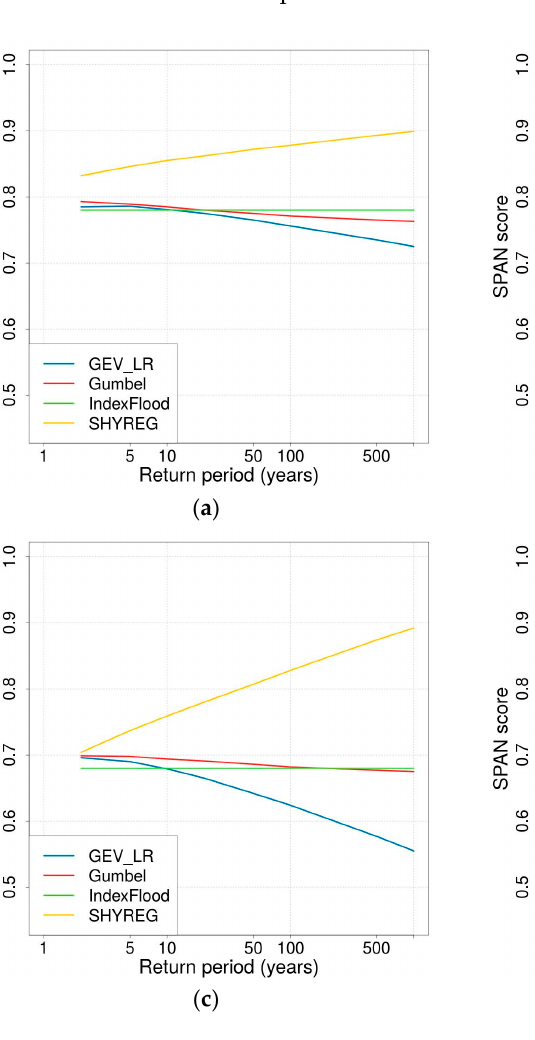
Figure 5. SPAN values for the different quantiles and the different regionalised FFAs. ( a ) All of France; ( b ) Plains zone; ( c ) Mediterranean zone; ( d ) Mountainous zone.